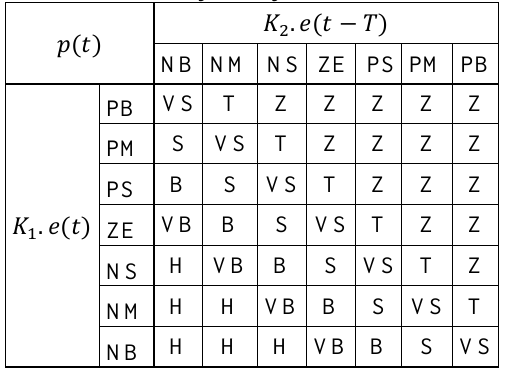
Table 1. Fuzzy rule system of FLRED